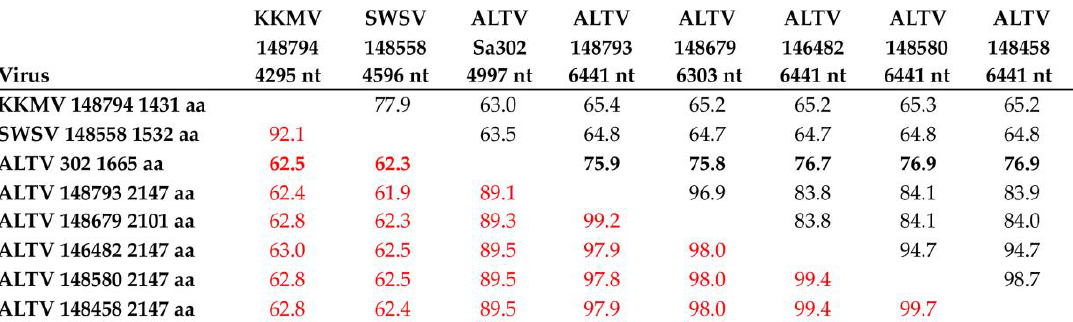
Figure 3. Pairwise alignment and comparison of nucleotide and amino acid L-segment sequences of prototype Kenkeme virus (KKMV Sr422 / MSB148794), Seewis virus (SWSV Sca371 / MSB148558), Altai virus (ALTV Telet-Sa302) and representative ALTV-like hantaviruses (Sca363 / MSB146482, Sca370 / MSB148580, Sca377 / MSB148458, Sca402 / MSB148793 and Sr424 /